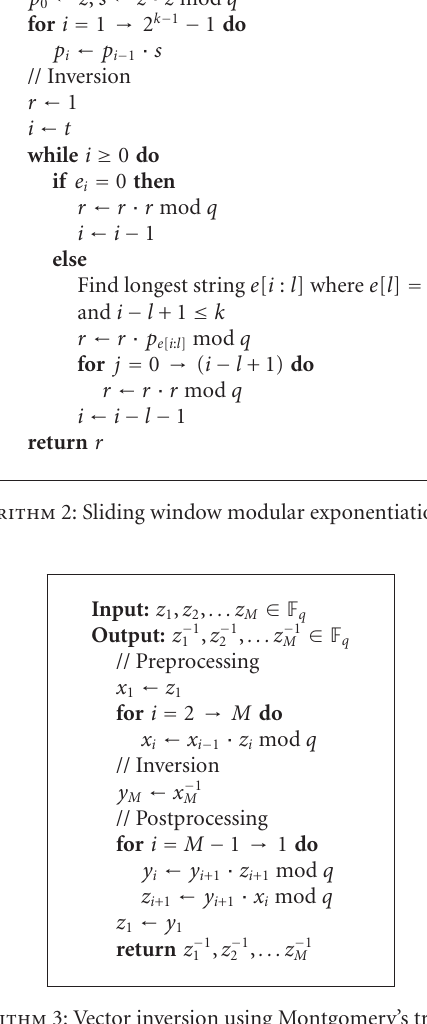
Algorithm 3: Vector inversion using Montgomery’s trick